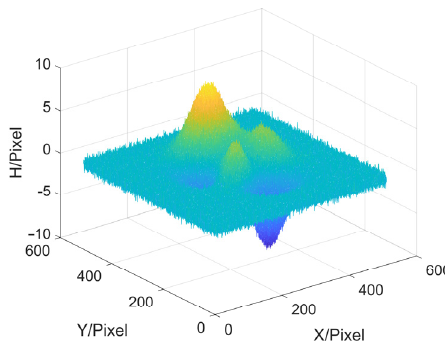
Figure 7. Object with noise to be tested.